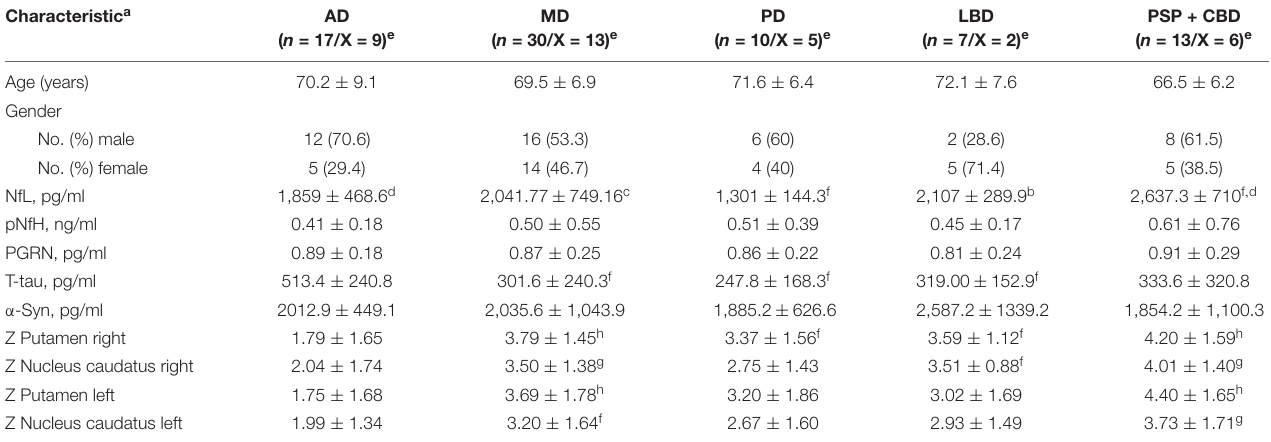
TABLE 1 | Epidemiology data on patients.